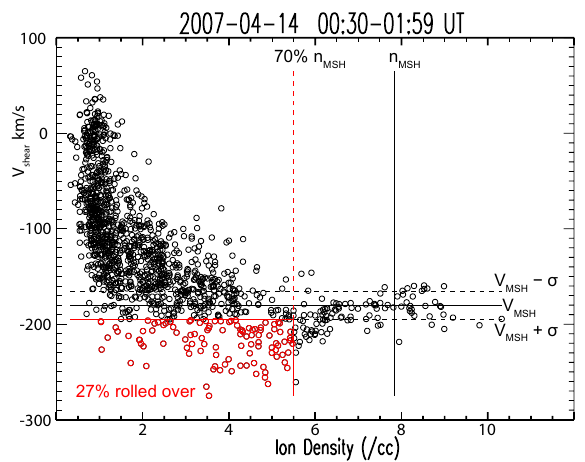
Fig. 2. A plot of shear velocity versus density for the event in Fig. 1. The plot is described in the text.